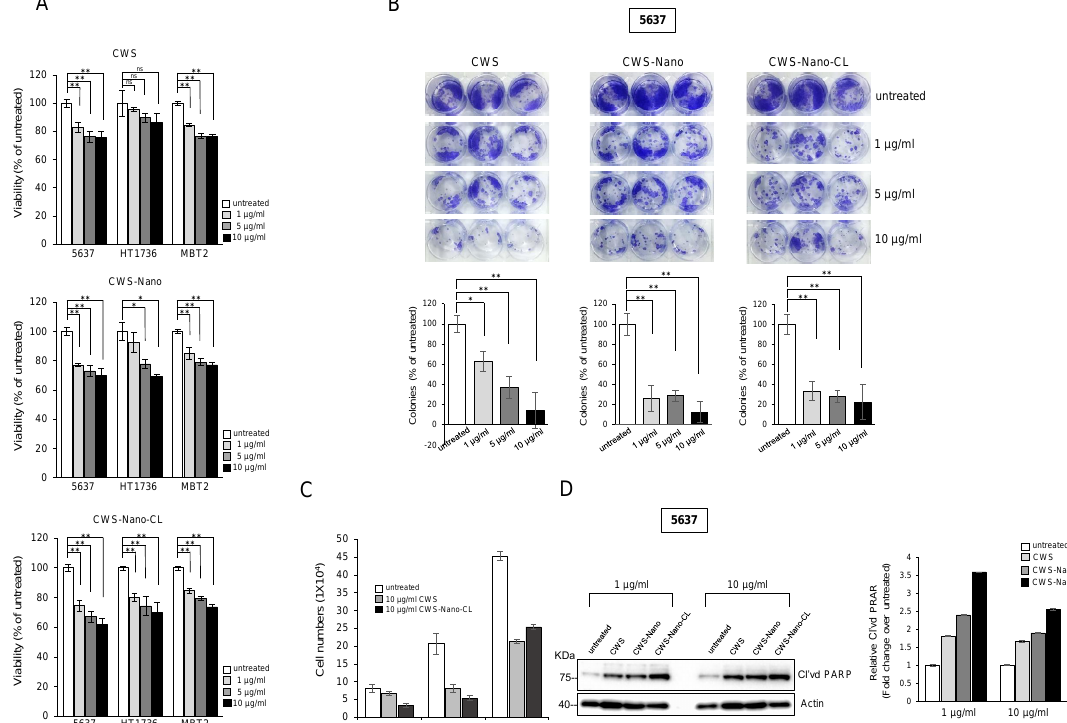
Figure 2. E ff ects of CWS-loaded formulation on growth inhibition in bladder cancer cells. ( A ) Human bladder cancer 5637 and HT1376 cells, and murine bladder cancer MBT2 cells were seeded in 96-well plates. Cells were treated with indicated concentrations of CWS-loaded formulations for 48 h, and then, cell viability was determined using MTT solution. * p < 0.005, ** p < 0.0005, ns: non-significant; untreated / CWS, untreated / CWS-Nano, or untreated / CWS-Nano-CL. Data are mean ± SEM ( n = 6). ( B ) Colony-forming ability of cells treated with CWS-loaded formulations (1, 5, and 10 µ g / mL) was measured after 2 weeks. * p < 0.005, ** p < 0.0001; untreated / CWS, untreated / CWS-Nano, or untreated / CWS-Nano-CL. Data are mean ± SEM ( n = 3). ( C ) Cell numbers were counted by staining with trypan blue at 24, 48, and 72 h after treatment with CWS-loaded formulation. * p < 0.05, ** p < 0.0005; untreated / CWS or untreated / CWS-Nano-CL. Data are mean ± SEM ( n = 3). ( D ) Levels of cleaved poly(ADP-ribose) polymerase (PARP) in cells treated with CWS-loaded formulations were analyzed by Western blotting. Actin was used as a loading control. The blots are representative of three independent experiments. The quantification graphs represent cleaved PARP (Cl’vd PARP) / Actin ratios determined by densitometric analyses. All expression ratios were normalized to the untreated